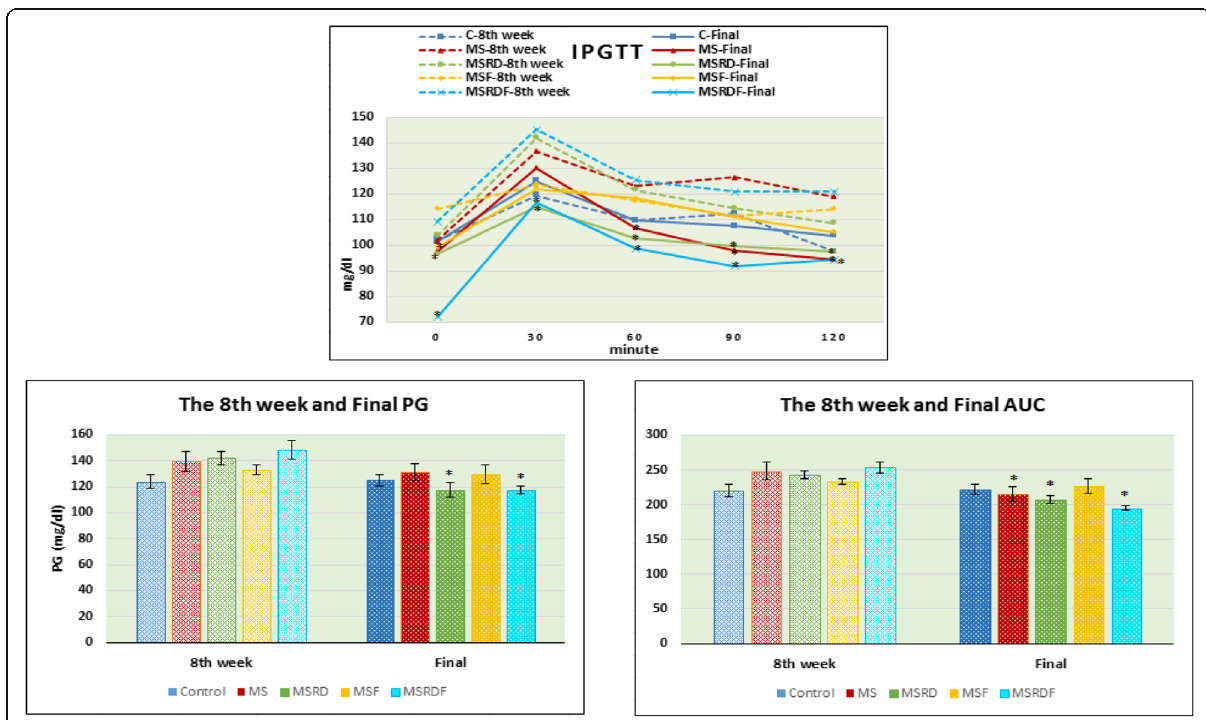
Fig. 3 The 8th week and final glucose homeostasis parameters in the five study groups. MS untreated metabolic syndrome group, MSRD metabolic syndrome group reverted to regular rat chow, MSF metabolic syndrome group on alternate day fasting, MSRDF metabolic syndrome group reverted to regular rat chow and on alternate day fasting, IPGTT intraperitoneal glucose tolerance test, PG peak glycemia, AUC area under the curve. Data are expressed as mean ± SEM. * Significance from 8th week value, by Student ’ s “ t ” test for paired data, at P ≤